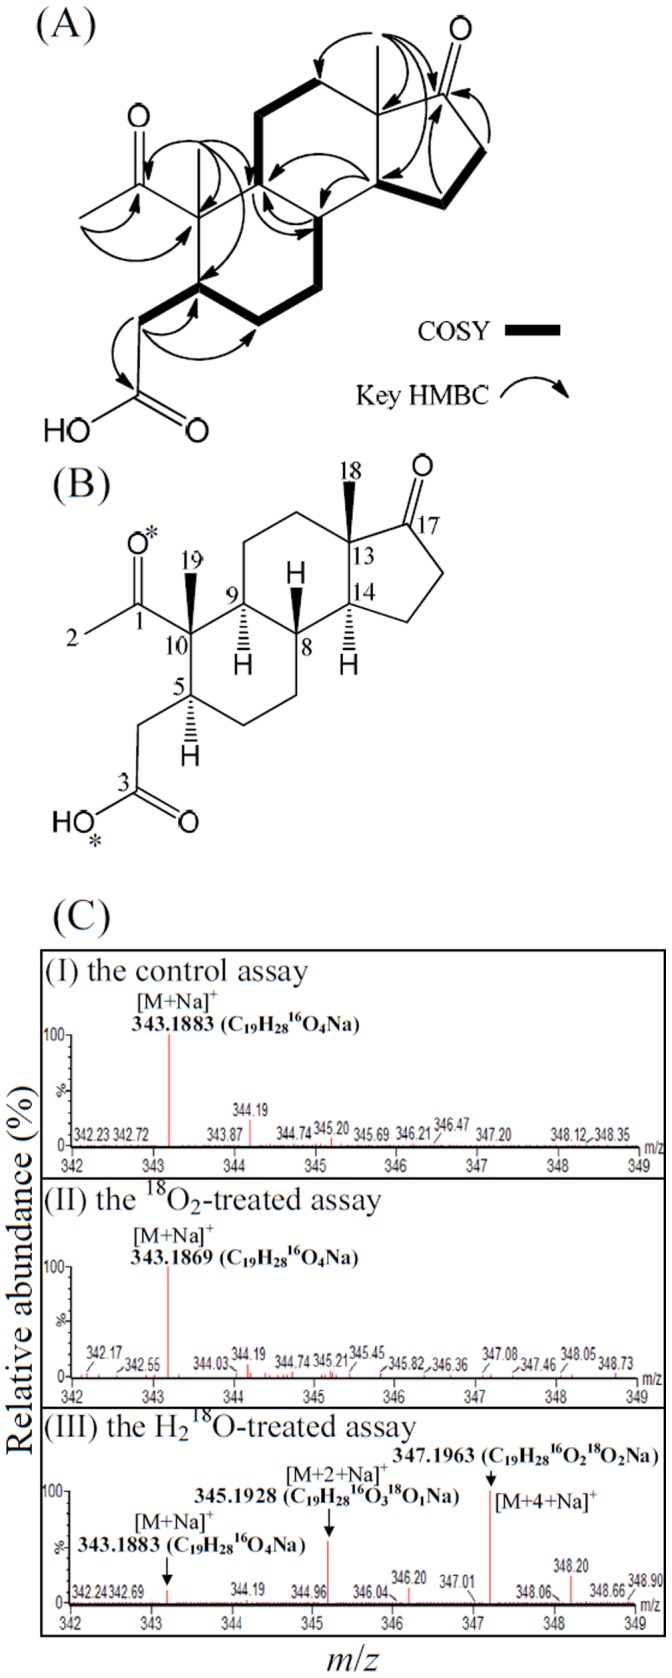
The structure elucidation and the investigation of the ring cleavage mechanism of compound 1 (1,17-dioxo-2,3-seco-androstan-3-oic acid, DSAO).(A) The interpretations of COSY and key HMBC spectra of compound 1. (B) The chemical structure of compound 1. *The oxygen atoms were labeled with 18O in the H2
18O-incorporation assay. (C) ESI-mass spectra (positive ion mode) of DSAO. (CI) DSAO purified from the anaerobic control assay. (CII) DSAO purified from the 18O2-treated assay. (CIII) DSAO purified from the 18O-labeled H2O-treated assay. For detailed NMR spectral data of compound 1, see Table S2.